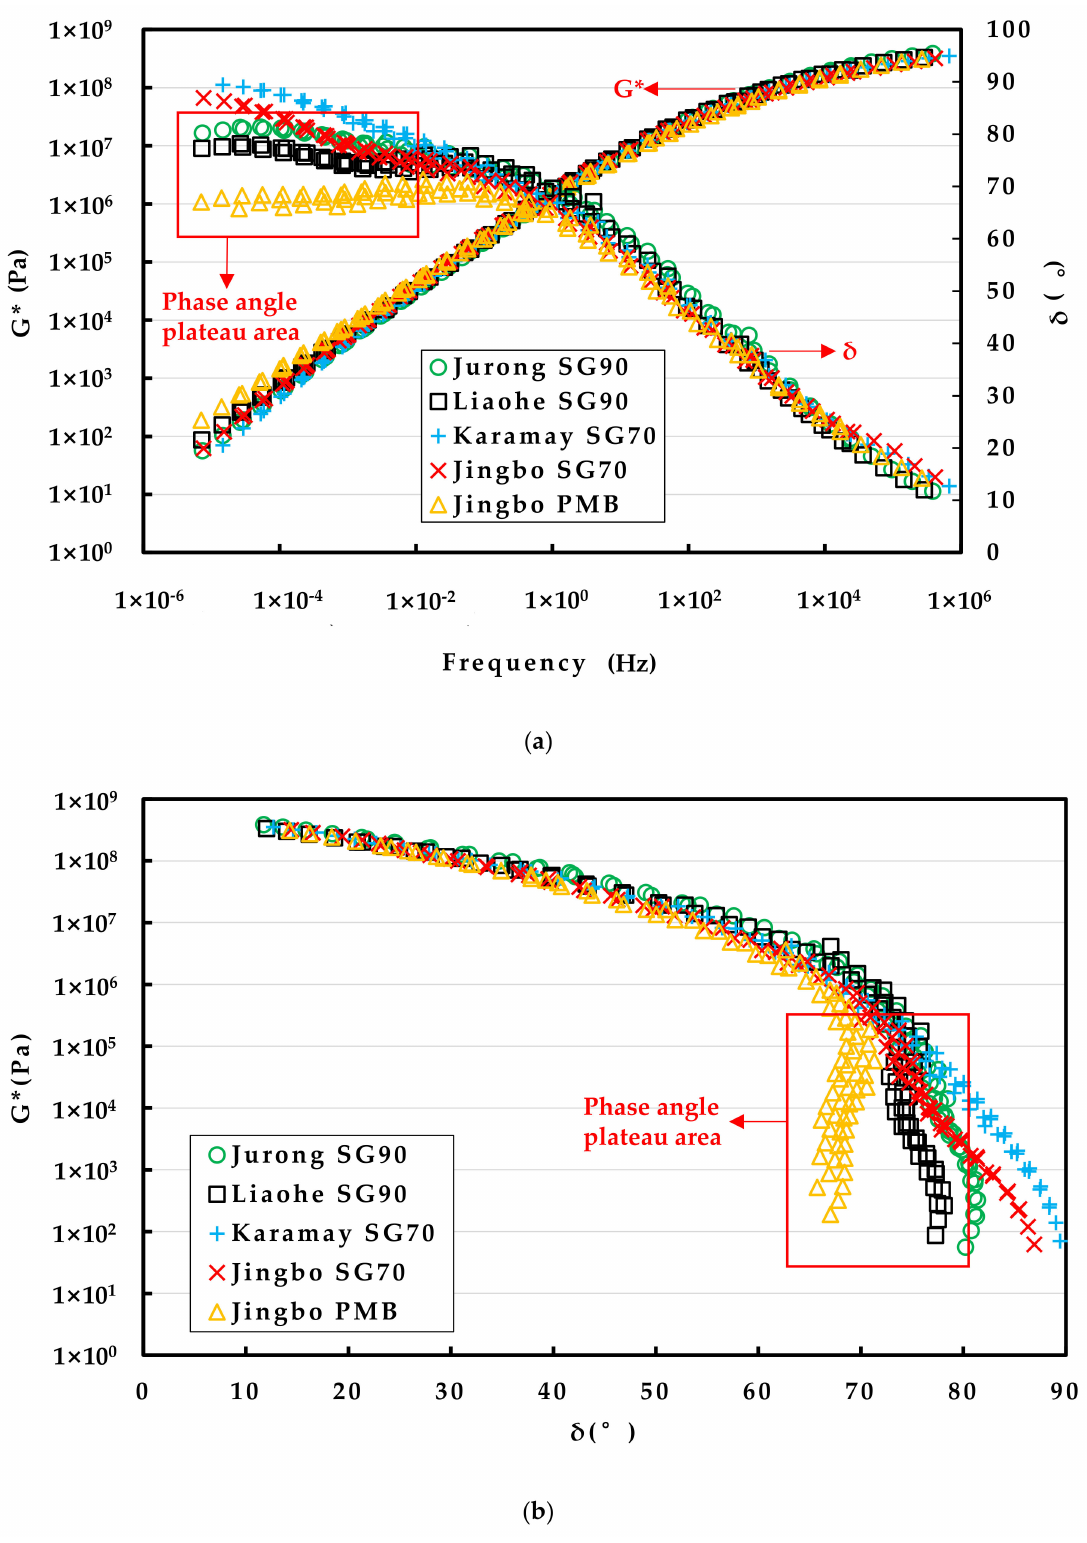
Figure 2. The master curves of complex modulus and phase angle of five hydraulic bitumen binders ( a ) and black diagrams ( b